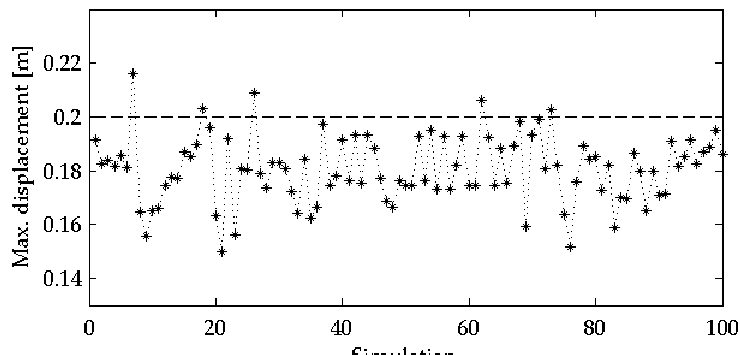
Figure 7. Maximum displacement at the mid-span of the stay cable with the elastomeric damper for the different elements of the sample.